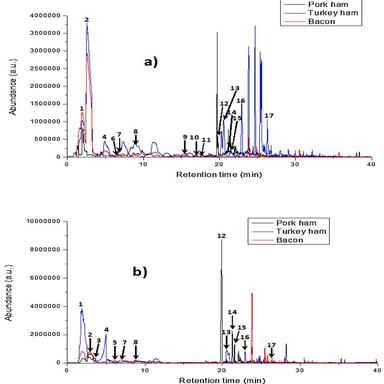
Chromatograms obtained by GC–MS analysis of processed meat products: pork ham, turkey ham and bacon. a) fresh products and b) after 35 days. Numbers in the figures refer to the compounds listen in.